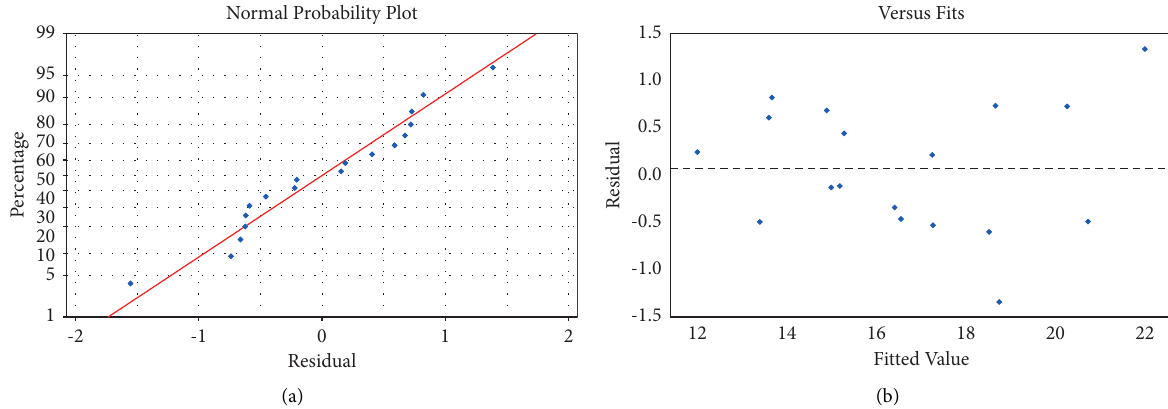
Figure 6: Statistical results for RPDD. (a) Normal probability plot (b) versus fits.